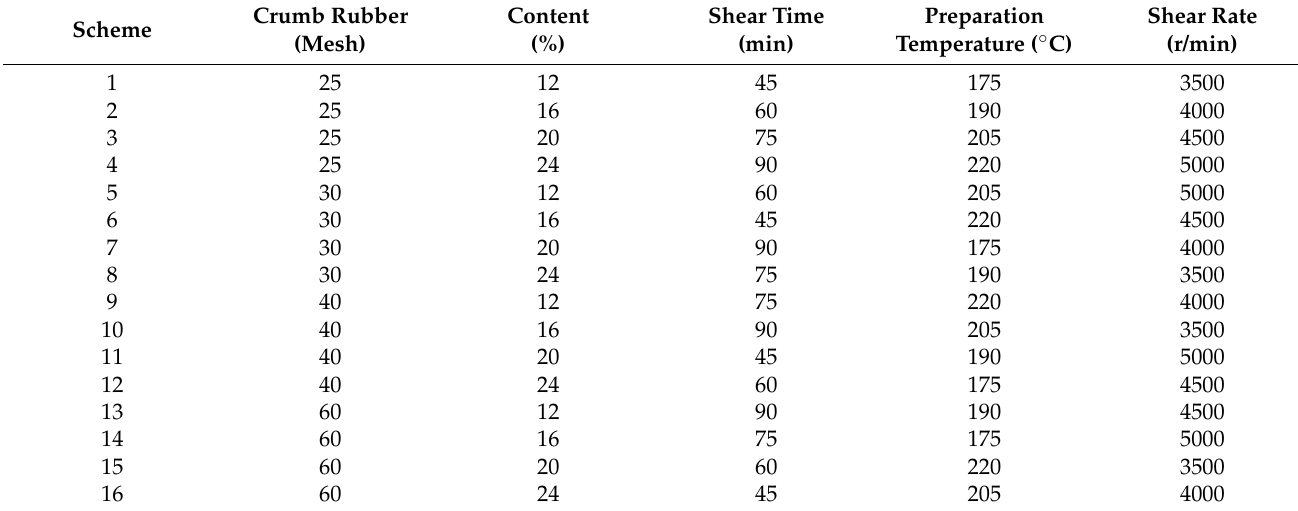
Table 7. Orthogonal test